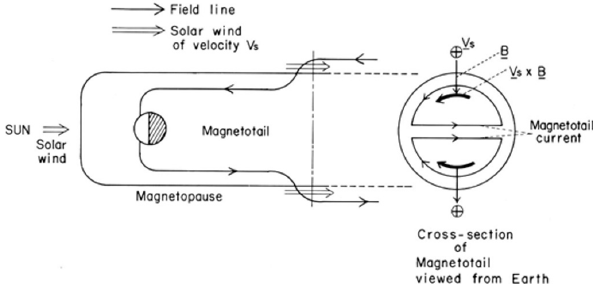
Fig. 7a. Schematic illustration of how the solar wind- magnetosphere dynamo works.